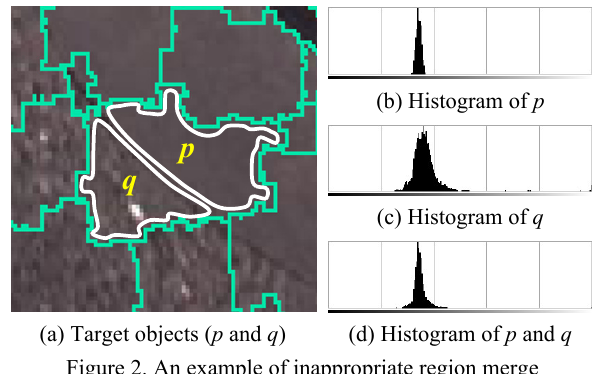
Figure 2. An example of inappropriate region